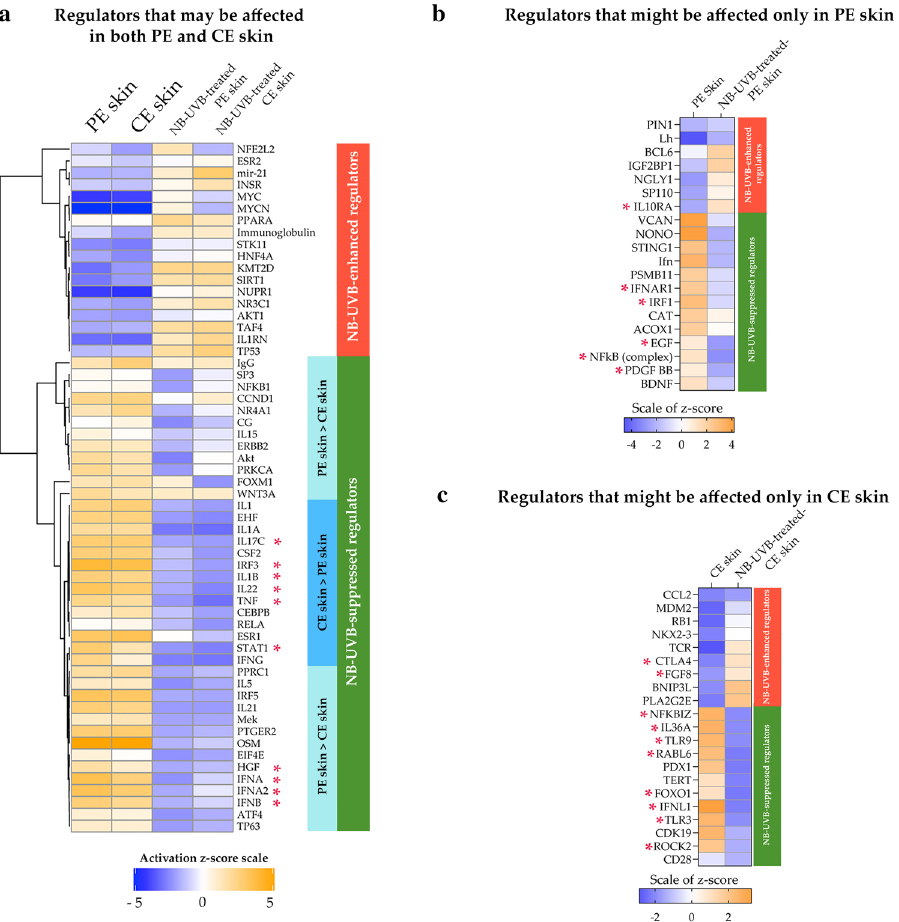
Figure 4. Effect of NB-UVB on potential upstream regulators. ( a ) Regulators that may be altered in both PE and CE skin. This cluster heatmap was created by “pheatmap” package in R software 1.0.12. ( b – c ) Regulators that might be altered either in PE skin or CE skin. Upstream regulators were analyzed by the upstream analysis function of QIAGEN’s IPA with a p -value of overlap < 0.05. The results are presented as a heatmap of the activation z-score. *indicates the potential key regulators. CE skin Center of lesional skin, NB‑UVB Narrow band ultra violet B, PE skin Peripheral edge of lesional